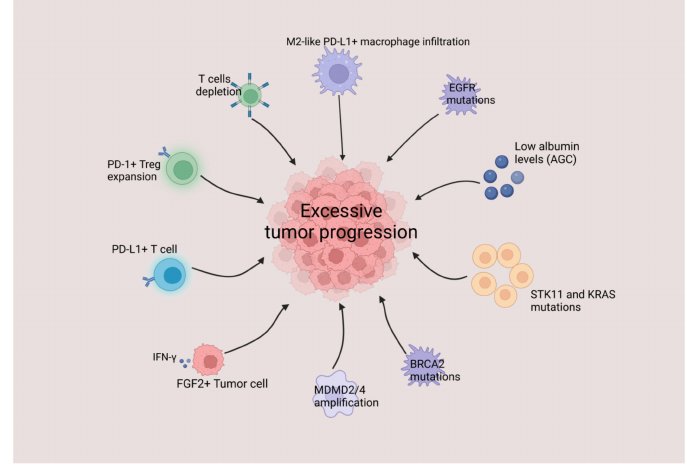
Figure 1. Possible biomarkers of